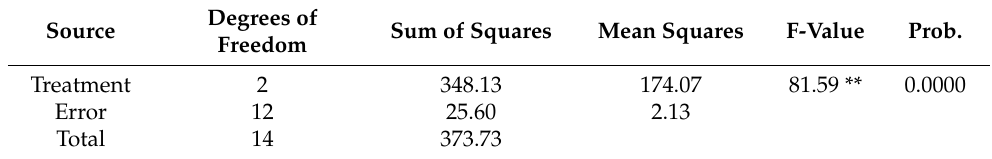
Degrees of Freedom